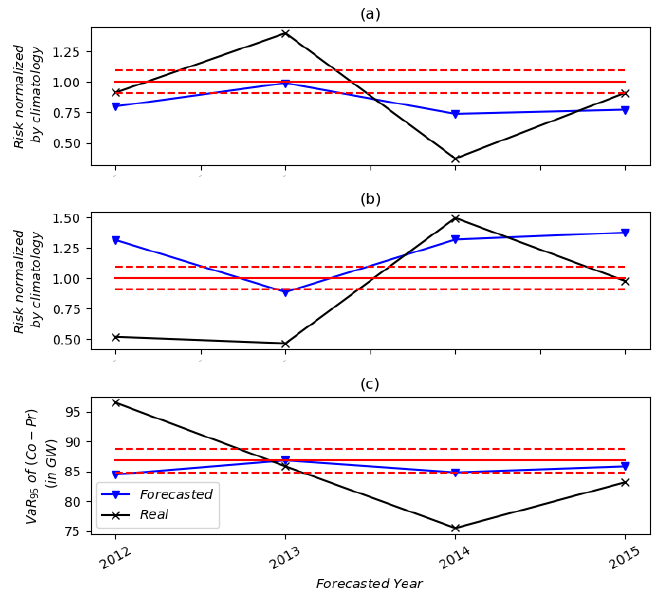
Figure 11. Same as Figure 9 for winters at the 3-month forecast horizon (January to